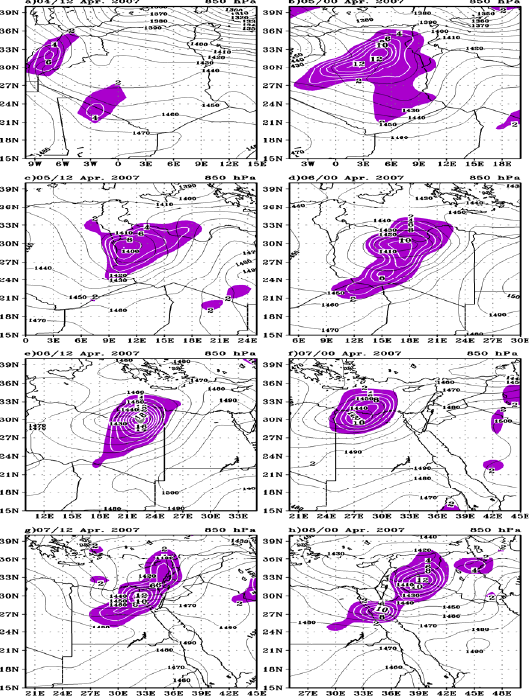
Figure 13. Frontogenesis regions (colored regions) at 850 hPa that ≥ 4 × 10 − 9 at 12Z and 00Z for 4–8 April 2007.